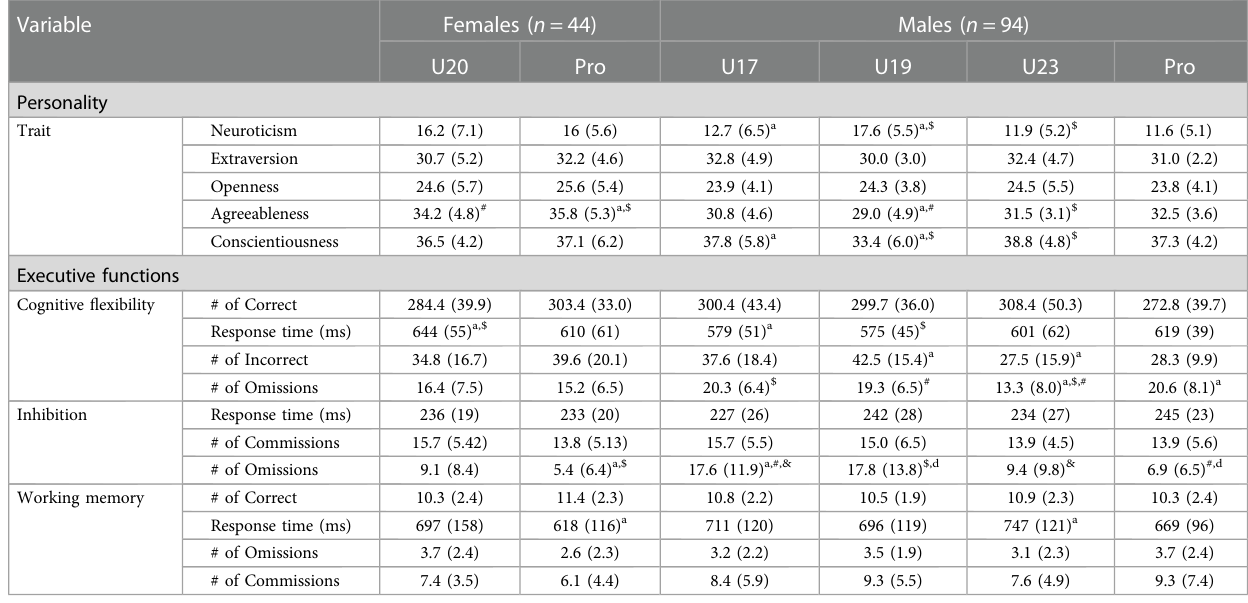
TABLE 2 Descriptive personality trait and EF statistics across each team ( n =138, mean; SD in brackets).